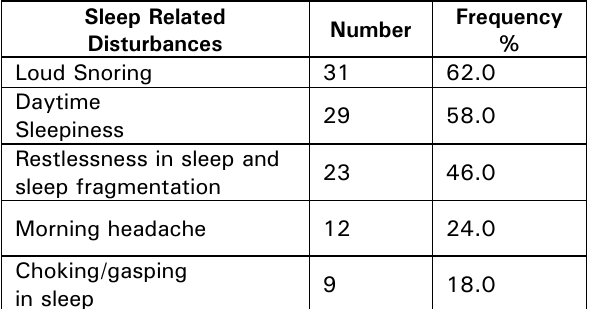
Table 2. Sleep related disturbances in patients with respiratory symptom complex attending routine respiratory clinical service